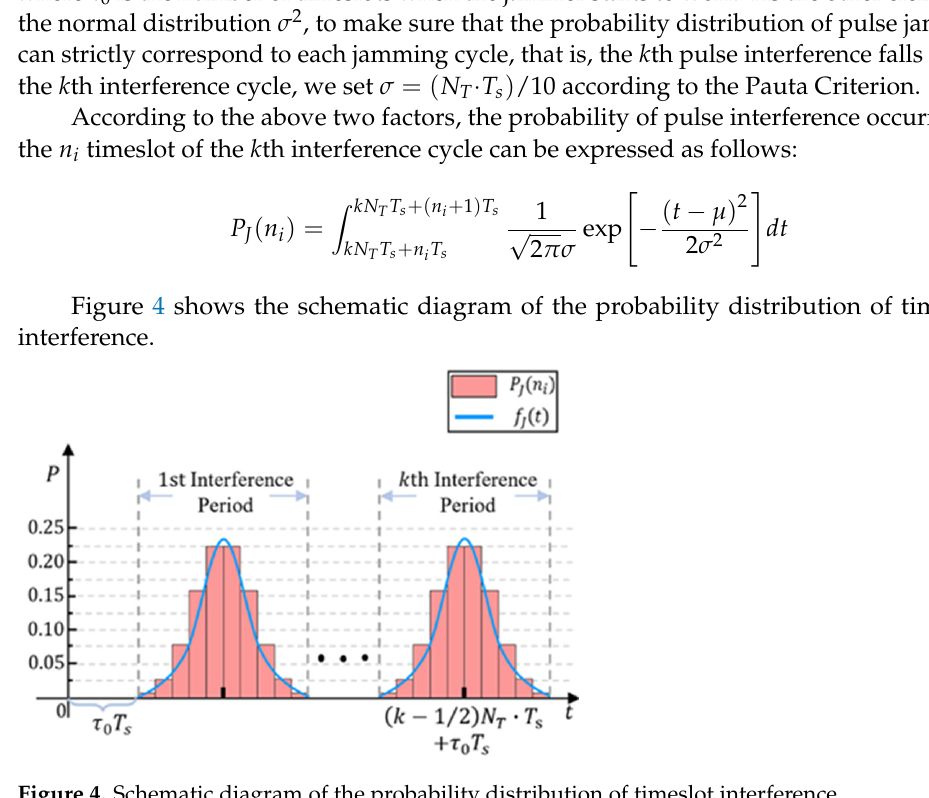
Figure 4. Schematic diagram of the probability distribution of timeslot interference.